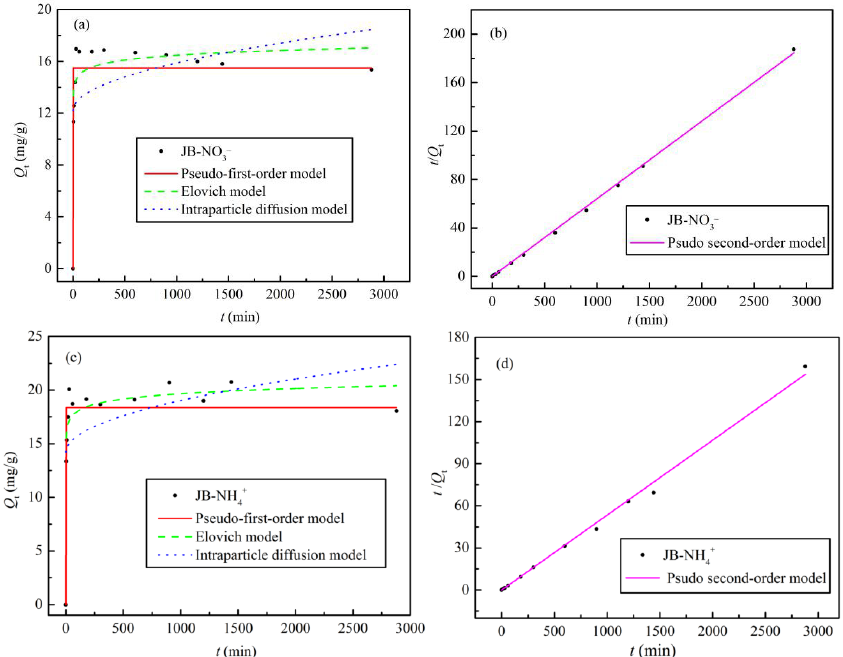
Table 5. Kinetic model parameters of NO 3 − and NH 4+ by JB